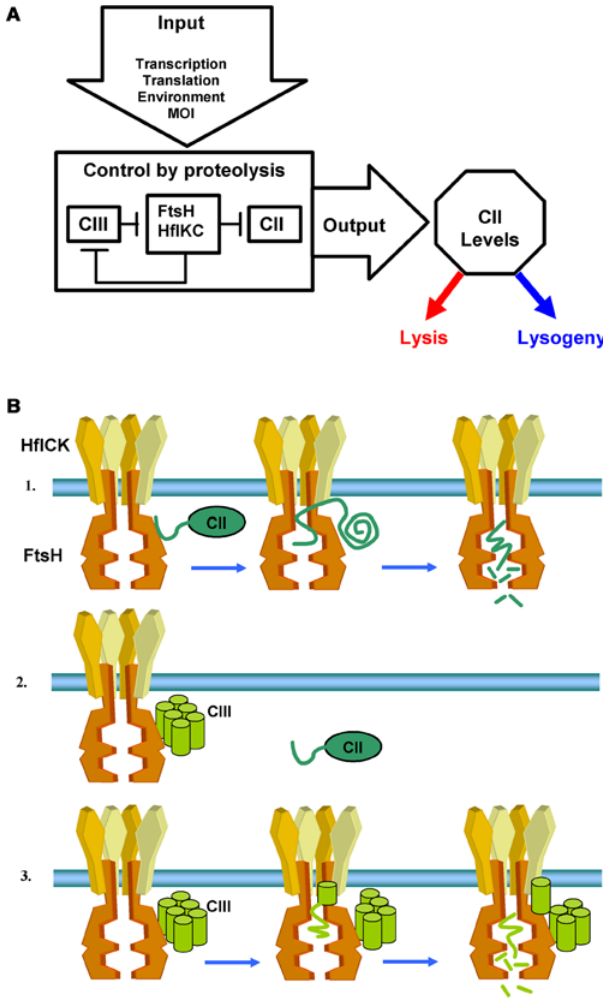
Figure 8. Schematic model for CIII activity. ( A ) The role of the CIII/CII/ FtsH/HflKC module in the lambda genetic decision. The FtsH and HflKC complex regulates CII and CIII levels and CIII controls FtsH/HflKC proteolytic activity. ( B ) A schematic drawing of the CIII mechanism of inhibition (based on the model presented in [16]). In panel 1 in the absence of CIII, CII binds the FtsH protease and is translocated into the enzymatic cavity where it is first unfolded and then degraded. In panel 2, CIII binds the FtsH protease and prevents CII from binding. In panel 3, the CIII protein, which is found as an oligomer, is also subjected to